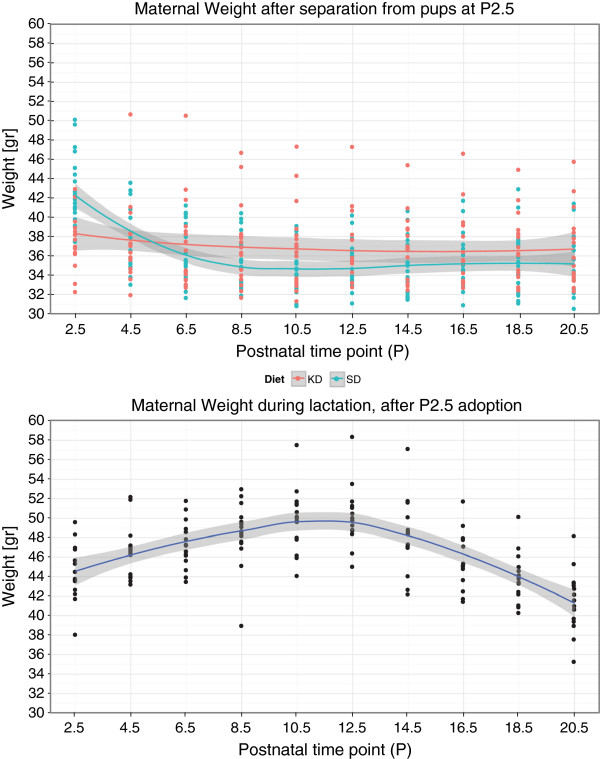
Maternal weight between P2.5 and P20.5 in (Top) the KD and SD control dams who were separated from their pups at P2.5, and in (Bottom) the lactating SD foster dams. Local regression is used to visualize the trend, where the shaded region indicates the standard error of the regression. (Top: NSD=19, NKD=17, Bottom: NLactating−FosterDams=15 per time point).